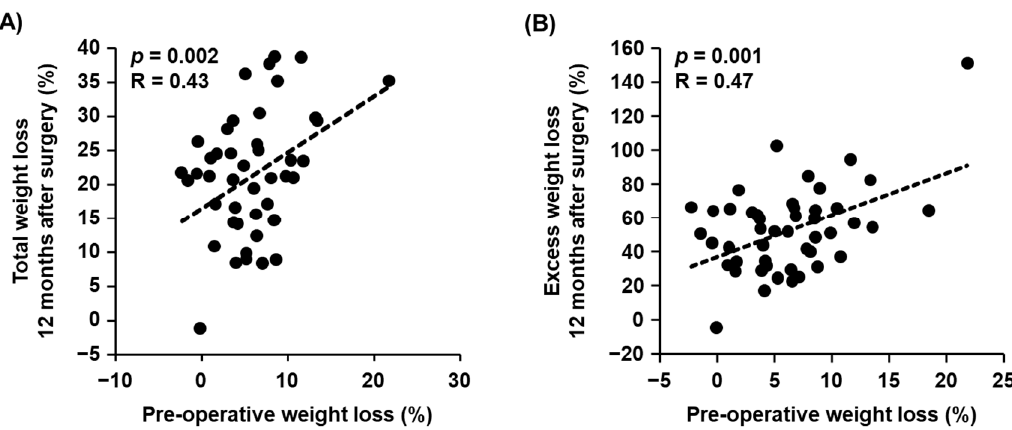
Figure 3. Relationship between weight loss during the pre-operative period and weight loss at 12 months after surgery. ( A , B ) Pearson’s correlation coefficient was used to examine the relationships between total weight loss during the pre-operative period and the percent of total weight loss ( p = 0.002, R = 0.43) ( A ) and the percent of excess weight loss ( p = 0.001, R = 0.47) ( B ).